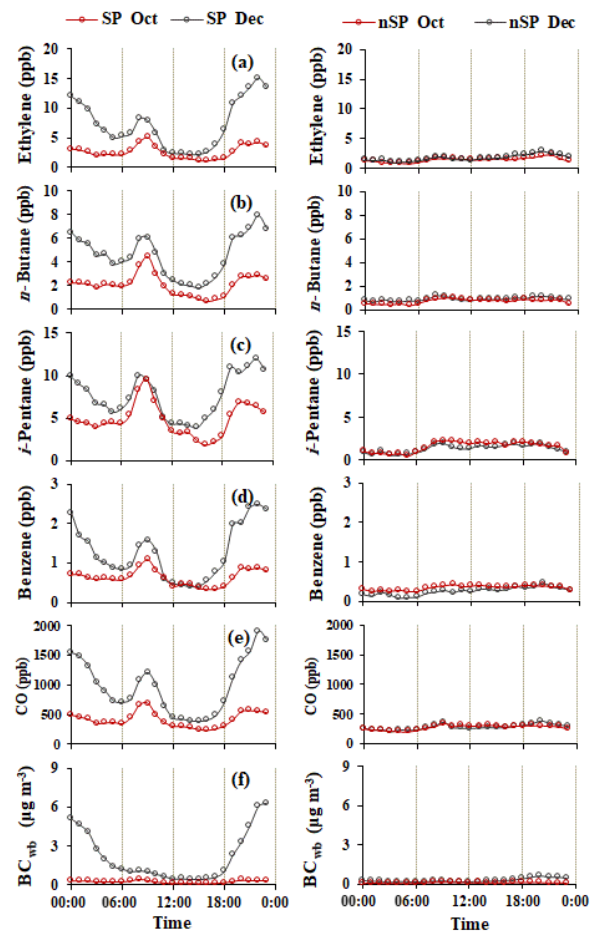
Figure 8. Diurnal patterns of (a) ethylene, (b) n- butane, (c) i- pentane, (d) benzene, (e) CO and (f) BC wb during the SPs (left col- umn) and nSPs (right column) identified during October 2015 (red) and December 2015 (black), respectively. Note: SP are defined by wind speeds lower than 3ms − 1 and the absence of rainfall, while nSP are defined by winds speeds higher than 3ms − 1